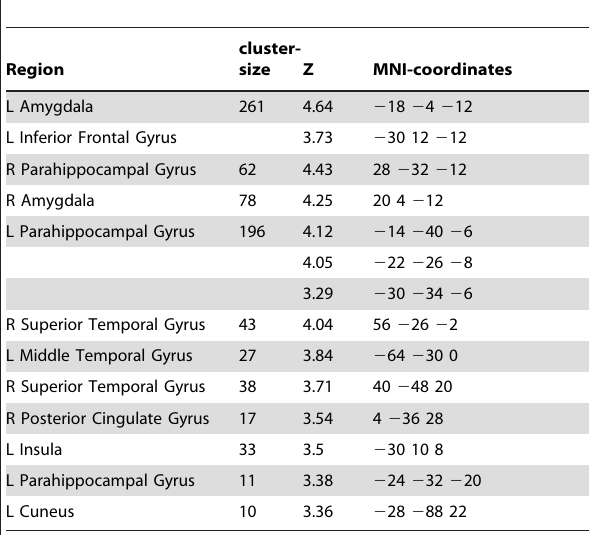
Table 2. Anatomical Site, Cluster Size, maximum Z value, and MNI coordinates of the local maxima for the connectivity analysis (seed in right ventral striatum [MNI coordinates 10 10 2 2], connectivity gamblers . controls).